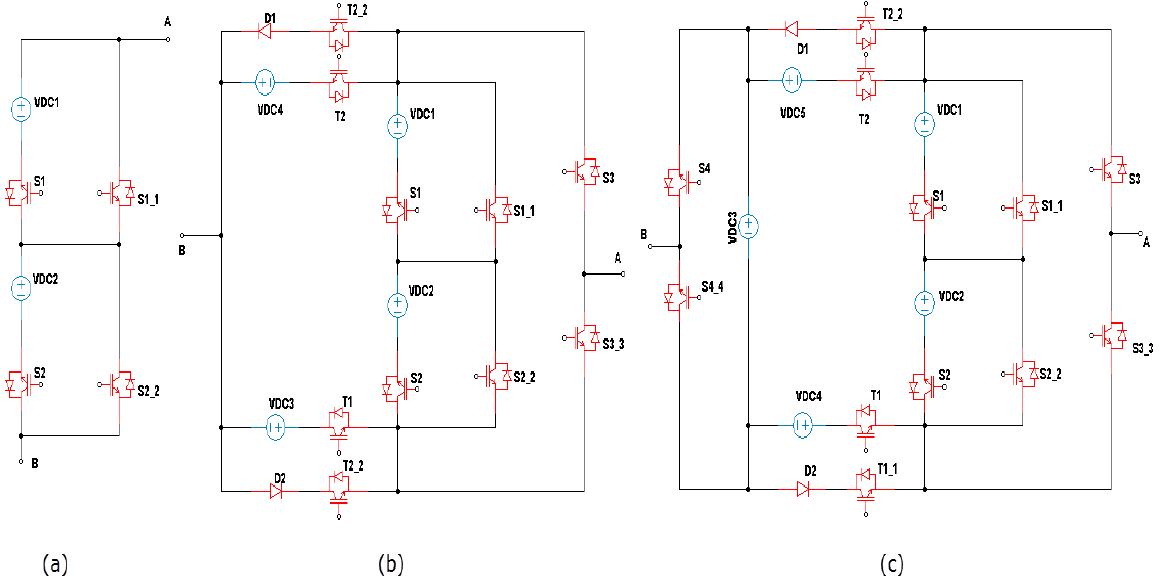
Figure 11. A modified T-MLI, ( a ) modified T-type converter, ( b ) modified T-type inverter, and ( c ) BBTHB proposed structure. Table 1. Output voltage and switch status for a modified 15-level T-MLI.